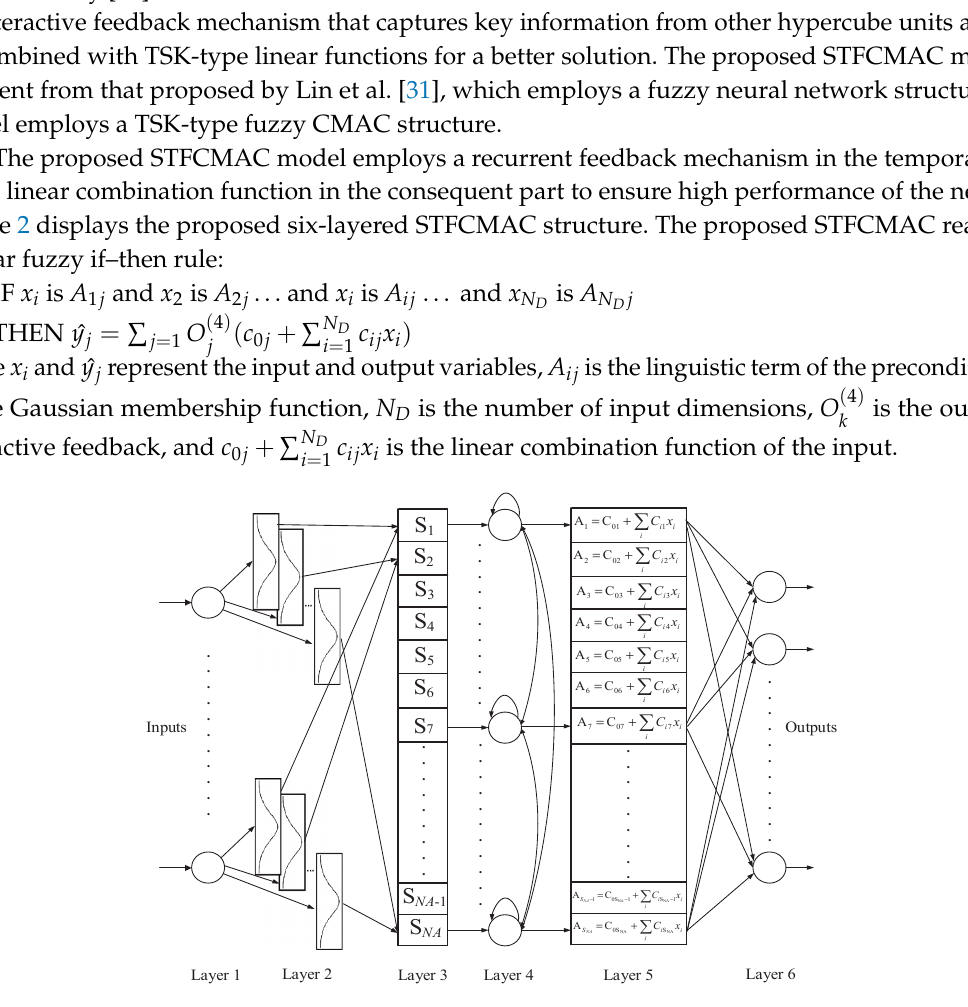
Figure 2. The proposed Self-evolving Takagi-Sugeno-Kang-type Fuzzy Cerebellar Model Articulation Controller (STFCMAC) model.